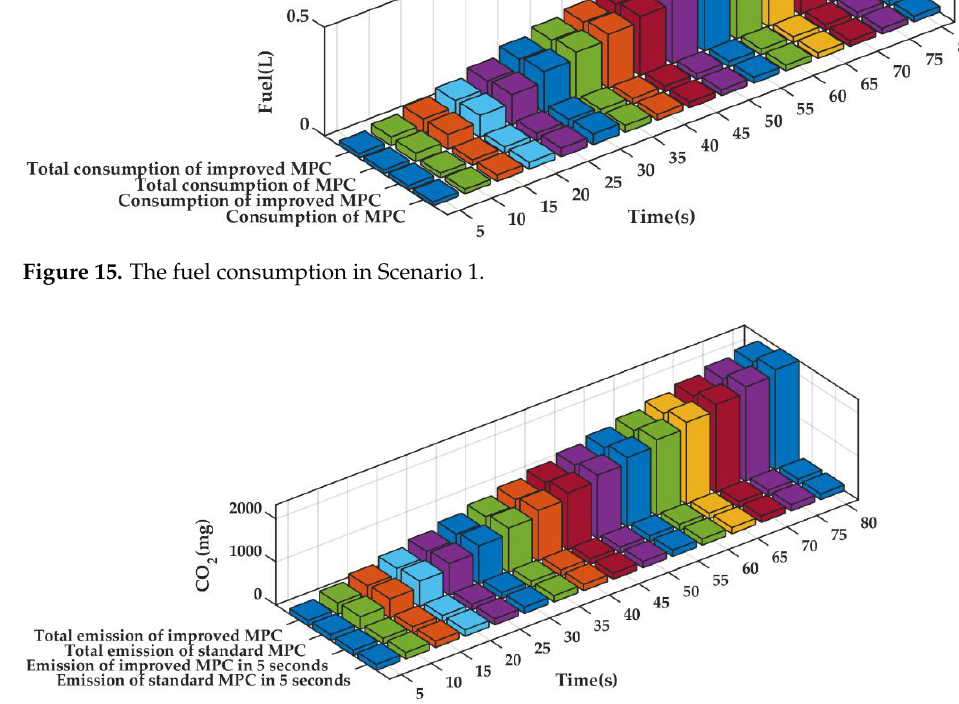
Figure 16. The carbon dioxide emissions in Scenario 1.